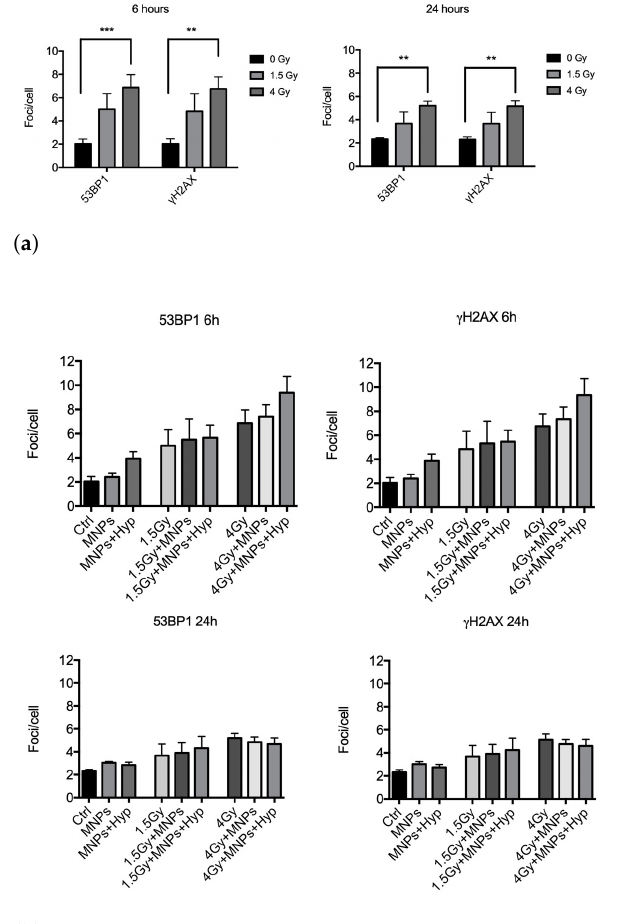
Figure 4. Analysis of 53BP1 and γ -H2AX foci induction in BxPC3 pancreatic tumor cells after 6 h and 24 h from the exposure to: ( a ) 1.5 and 4 Gy of photon irradiation alone ( Mode 1 ); ( b ) no dose (control, Ctrl) or photon irradiation in combination with MNP uptake ( Mode 2 ) and MNPs uptake+Hyp ( Mode 3 ). ** indicates p -value p < 0.01, *** indicates p < 0.005 (one-way ANOVA and Tukey’s multiple comparison